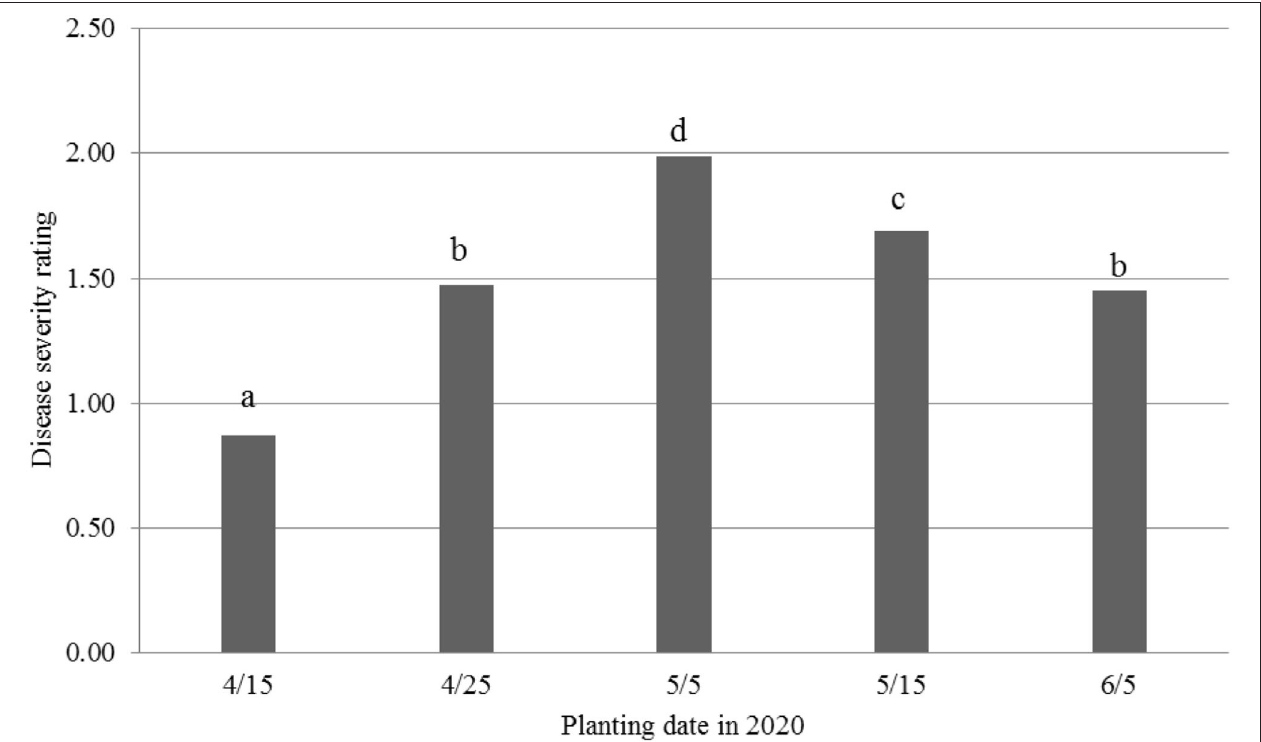
FIGURE 1 | Disease severity ratings from Fusarium oxysporum f. sp. vasinfectum race 4 in cotton at five different planting dates in 2020, 30 days post-inoculation. Individual plants were rated for disease severity based on the following scale: 0, no symptom; one wilted cotyledon; 2, two wilted cotyledons or two cotyledons abscised; 3, first true leaf wilted or three leaves abscised; 4, whole plant wilted or more than three leaves abscised; and 5, complete defoliation or plant death. Different letters above the bars indicate significant